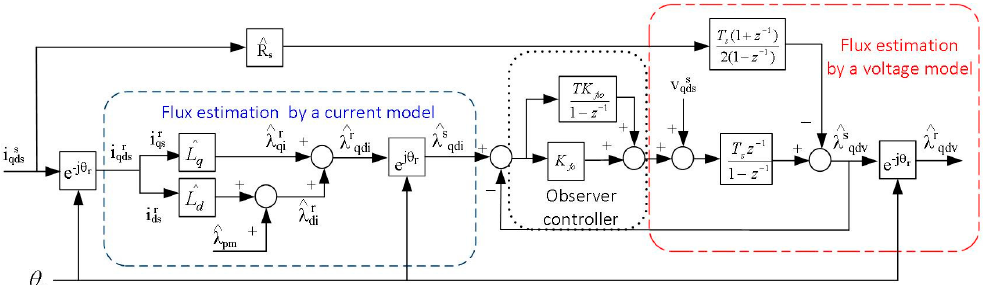
Figure 1. A block diagram of a Gopinath style stator flux linkage observer used for implementing the proposed torque error compensation algorithm.